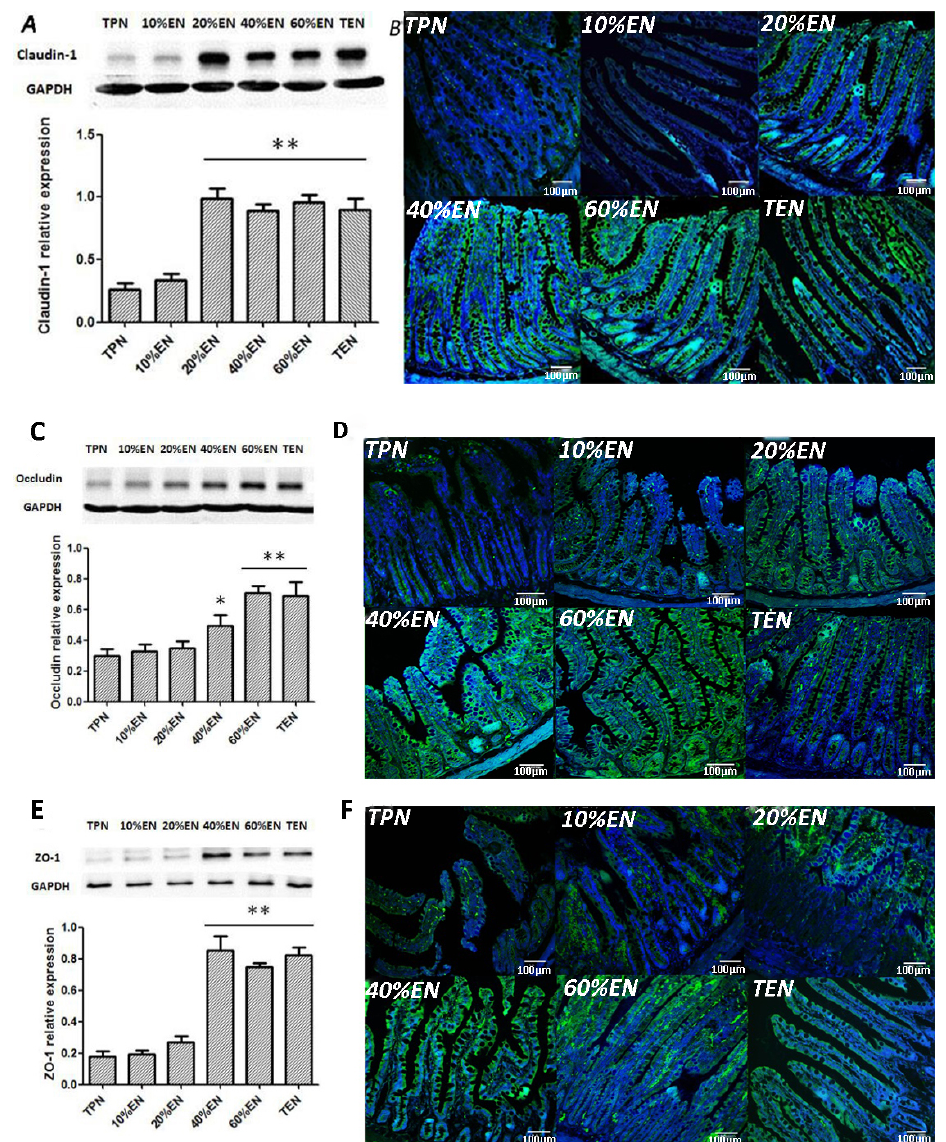
Figure 2. The expression of claudin ‐ 1, occludin and ZO ‐ 1 protein. ( A ) Western blotting analysis of claudin ‐ 1 protein. Apparently, 20% and more EN groups had an increased claudin ‐ 1 concentration compared with TPN ( p = 0.006, 0.006, 0.006, and 0.005, respectively). No statistical difference was found between TPN the 10%EN groups; ( B ) Immunofluorescence analysis of claudin ‐ 1 (green) and DAPI (blue); ( C ) Western blotting analysis of occludin. Compared with TPN, it seems that 40% is the minimally effective EN dose for raising the occludin expression ( p = 0.028). In 60% and 100%EN, more significant increase was found ( p = 0.006 and 0.007); ( D ) Immunofluorescence analysis of occludin (green) and DAPI (blue); ( E ) Western blotting analysis of ZO ‐ 1 protein. Similar trend of ZO ‐ 1 expression was found between groups ( p = 0.007, 0.009, and 0.009 compared with the TPN group). Furthermore, it seems that 40%EN had the same efficiency in maintenance of ZO ‐ 1 abundance compared with 60% and TEN; ( F ) Immunofluorescence analysis of ZO ‐ 1 (green) and DAPI (blue). * p < 0.05, compared with TPN group; ** p < 0.01, compared with TPN group.